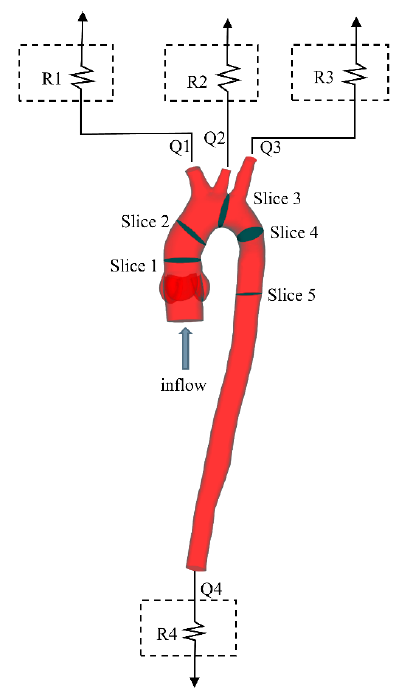
Figure 3. Zero-dimensional (0D) lumped parameter models with the 3D aorta model at the efferent arteries.